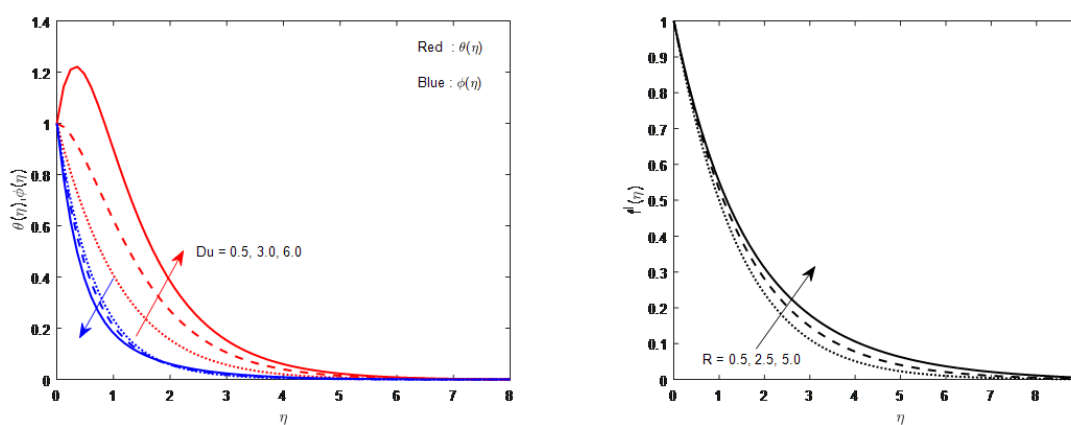
Figure 8: Velocity profiles for different values of radiation